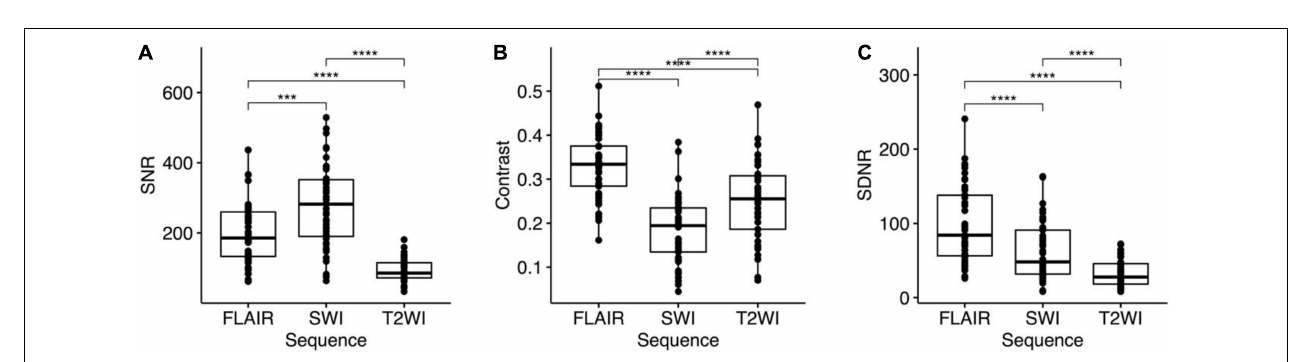
FIGURE 4 | Along the trajectory of STN-DBS electrodes, we reconstructed the oblique sagittal images on FLAIR (A) , T2WI (B) , and SWI (C) . On the oblique sagittal images, we evaluate the delineation between STN (indicated by black arrows on figures) and substantia nigra (indicated by white arrows). We also reconstructed the oblique axial images perpendicularly to the trajectory at the level of the STN on FLAIR (D) , T2WI (E) , and SWI (F) . On the oblique axial images, we evaluate the delineation of the lateral border of STN (indicated by black arrows).